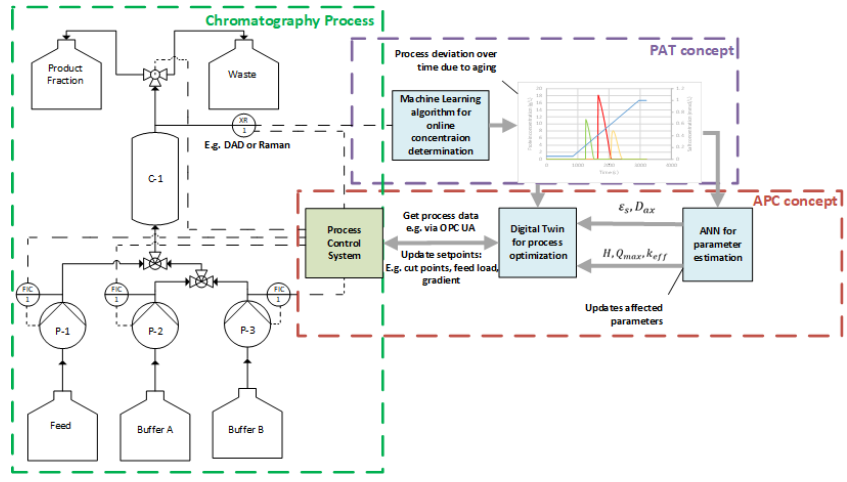
Figure 1. Advanced process control concept for process chromatography — batch and continuous.